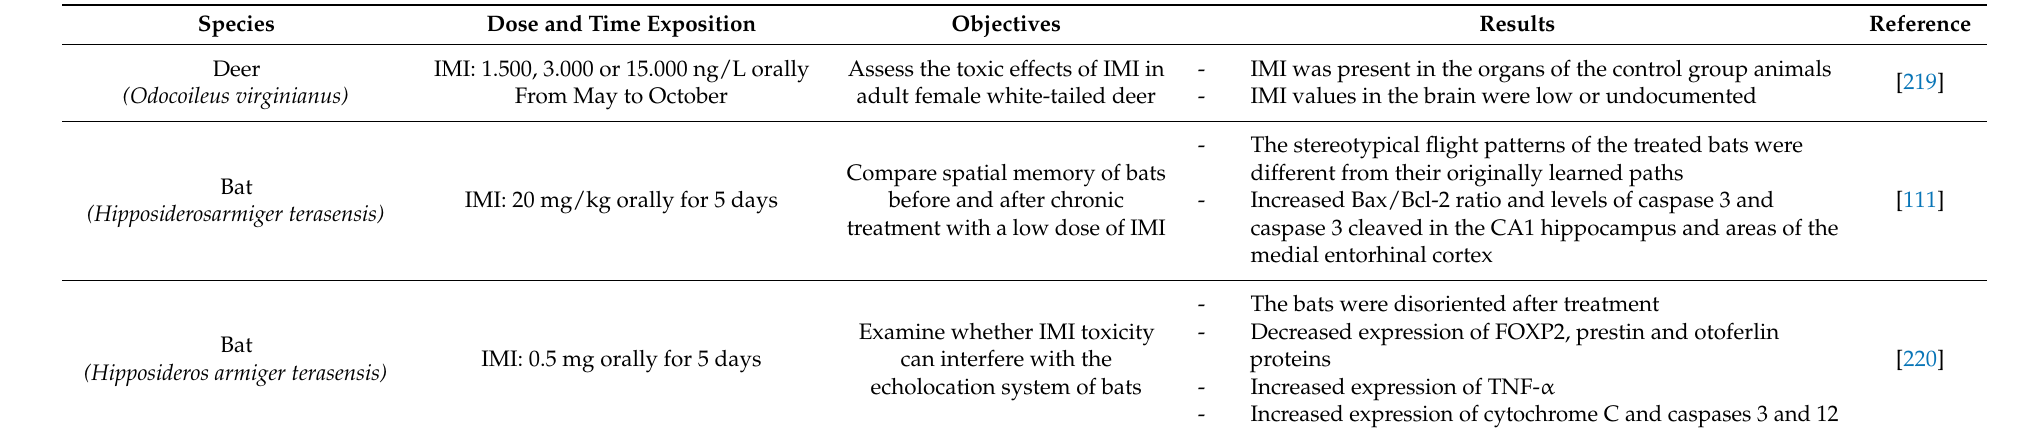
Table 5. Neurotoxic effects of neonicotinoid pesticides in other mammalian